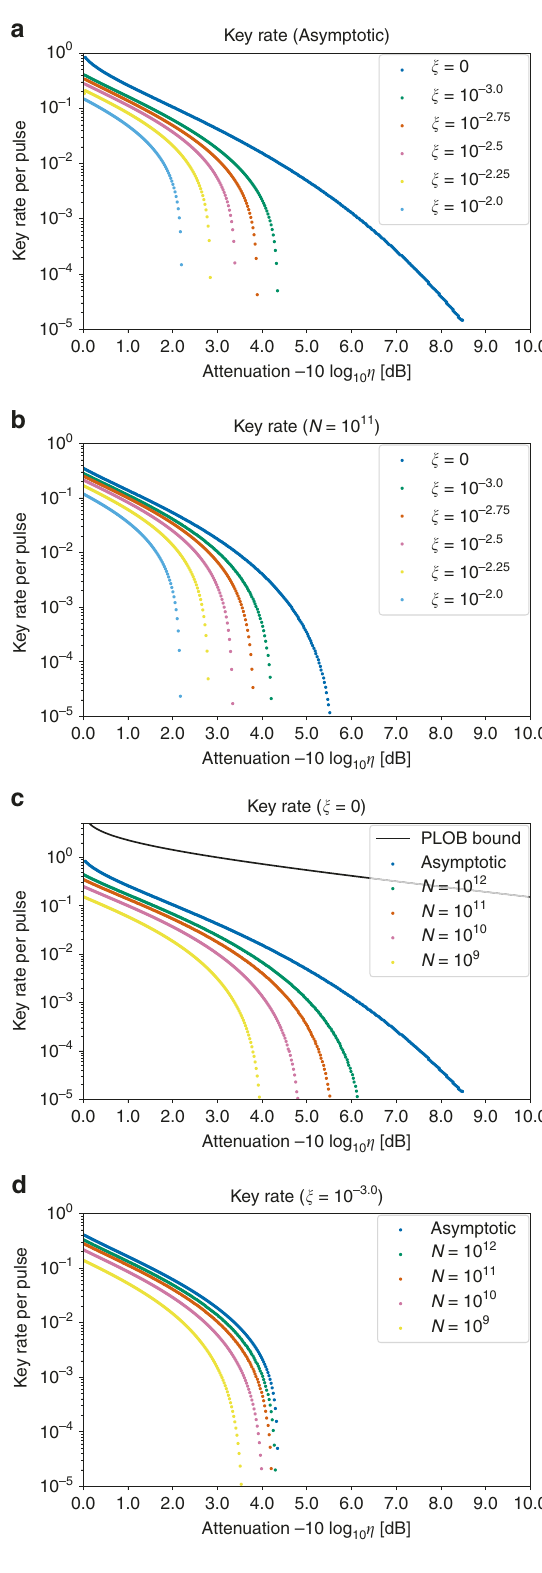
ðj ^ ω ± β j 2 Þ with m ; r ðj ^ ω ± β j 2 Þ : ^ ω 2 Ω ð ω Þg . As seen m ; r dig